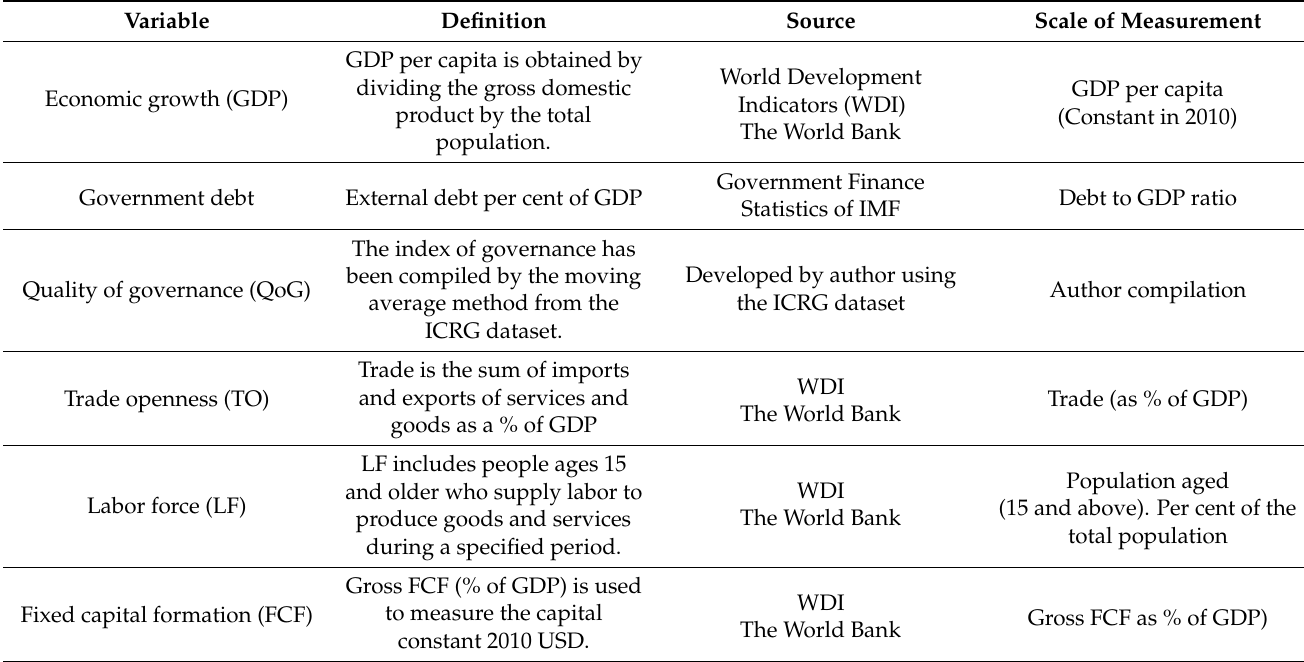
Table 1. Variable description and